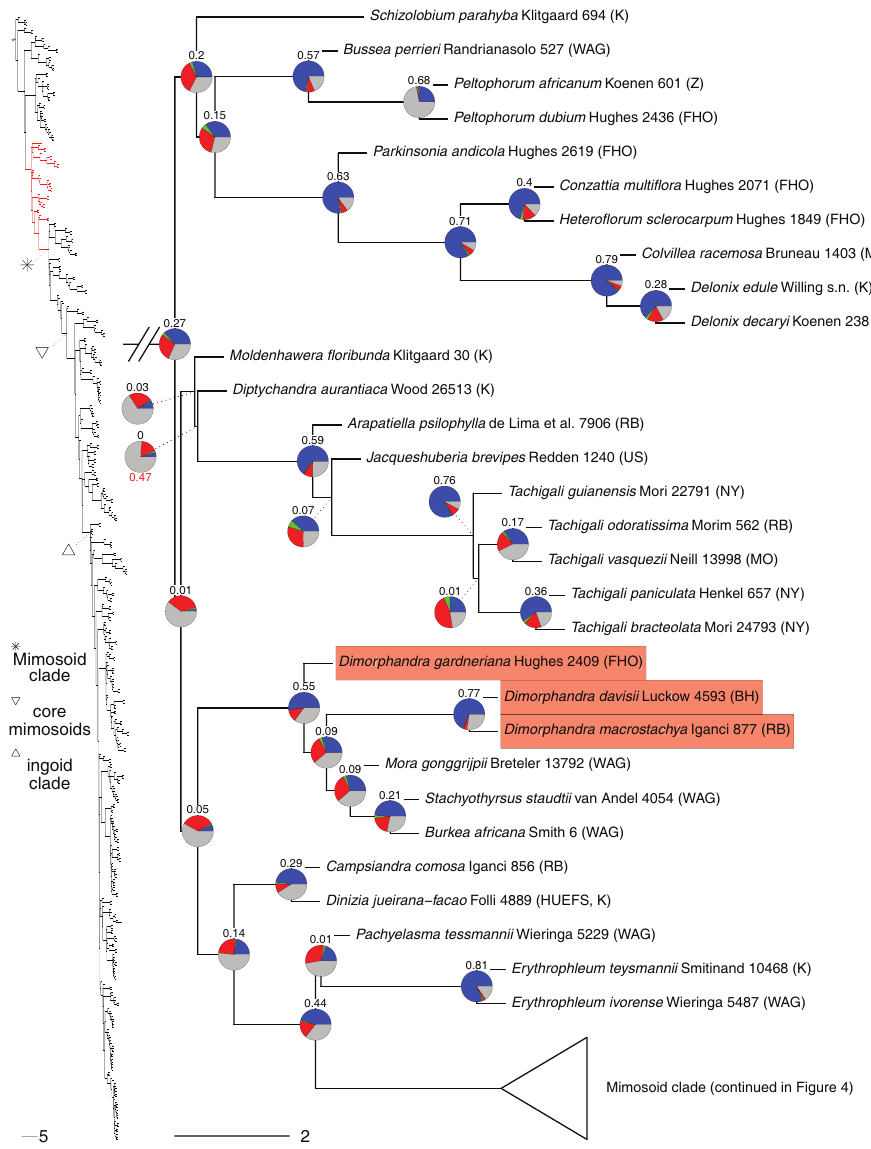
Figure 3. Phylogeny of Caesalpinioideae (continued). See Figure 2 for caption. Barneby & J.W. Grimes and Z. sabatieri Barneby & J.W. Grimes form the sister clade of Inga or a grade subtending Inga